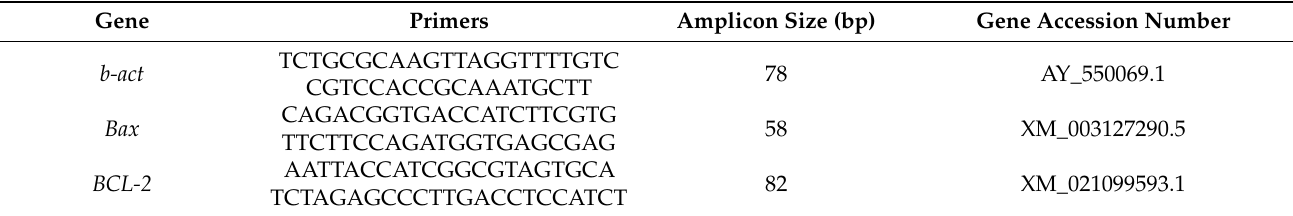
Table 1. Primer sequences used for Real-Time PCR.